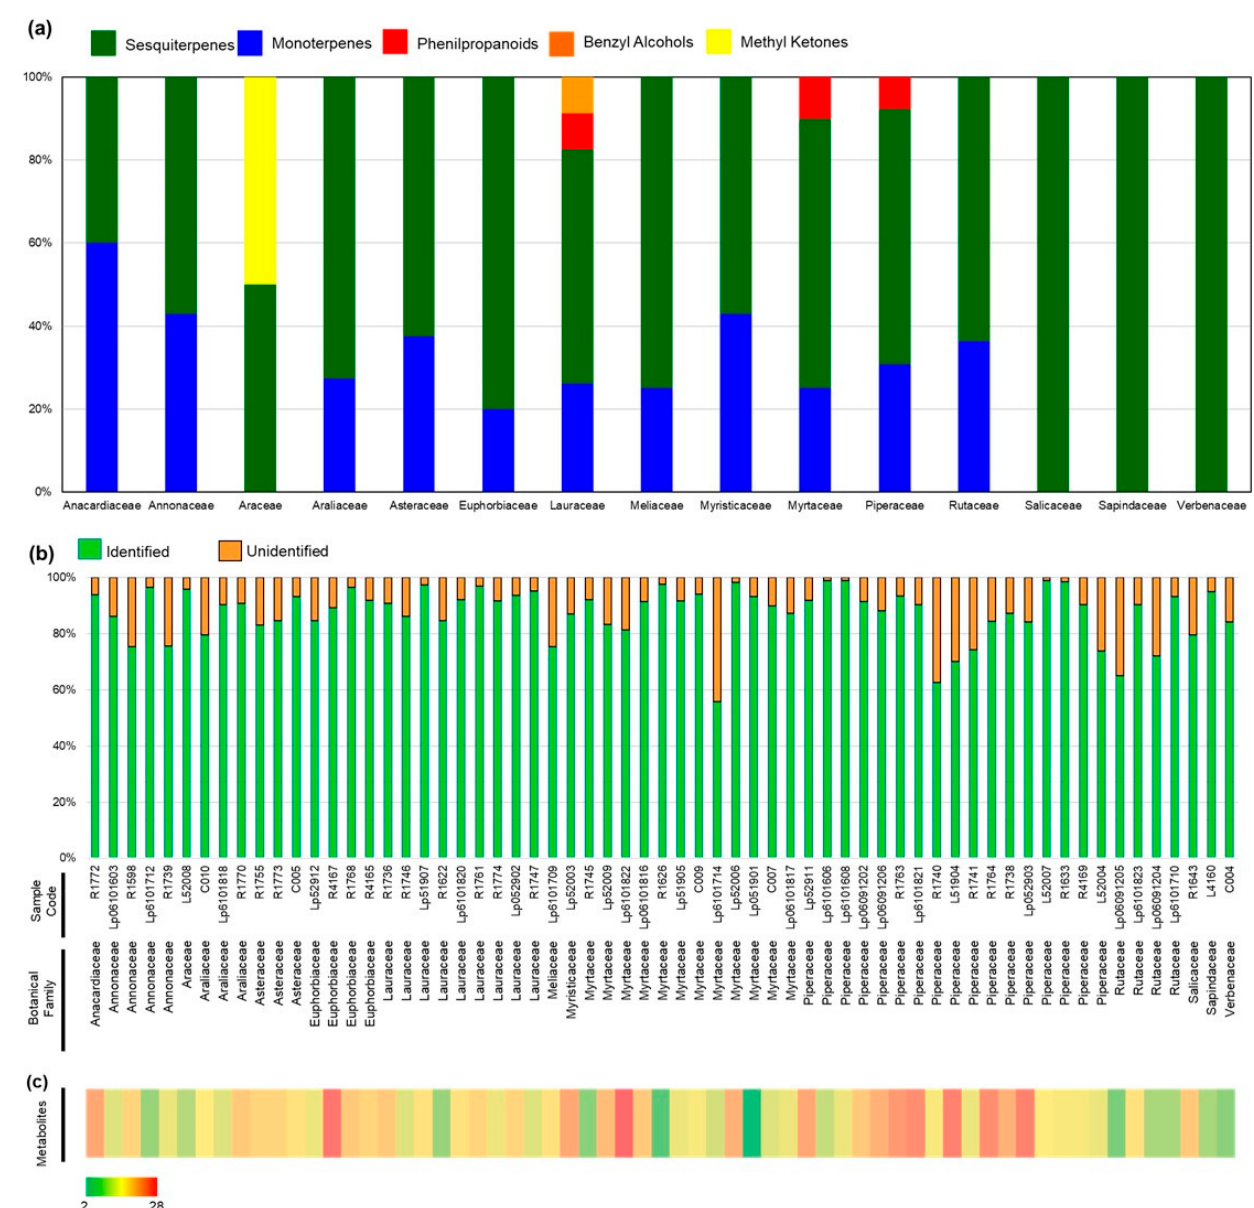
Figure 1. Summary of the metabolite profiles of aromatic plants from the Atlantic Rainforest. ( a ) Percentage of identified metabolites per chemical class for each botanical family. ( b ) Percentage of unidentified features per EO. ( c ) Chemical complexity of EO samples represented as heatmap. The identified metabolites were classified in monoterpenes (MT) (29%), sesquiterpenes (ST) (56%), phenylpropanoids (PP) (7.5%), benzenoids (BA) (3%), and ketones (MK)